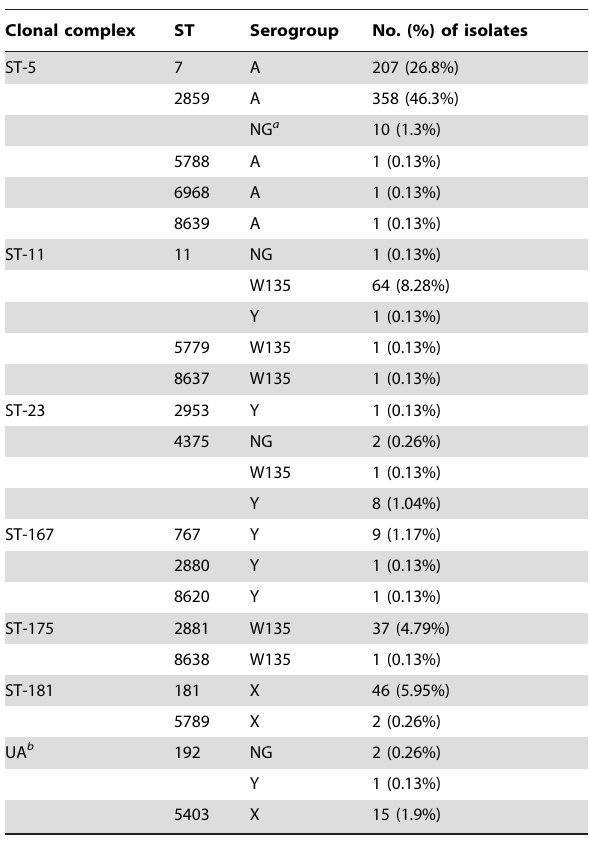
Table 3. Distribution of lineages found among 773 N. meningitidis strains isolated in the African meningitis belt between 2004 and